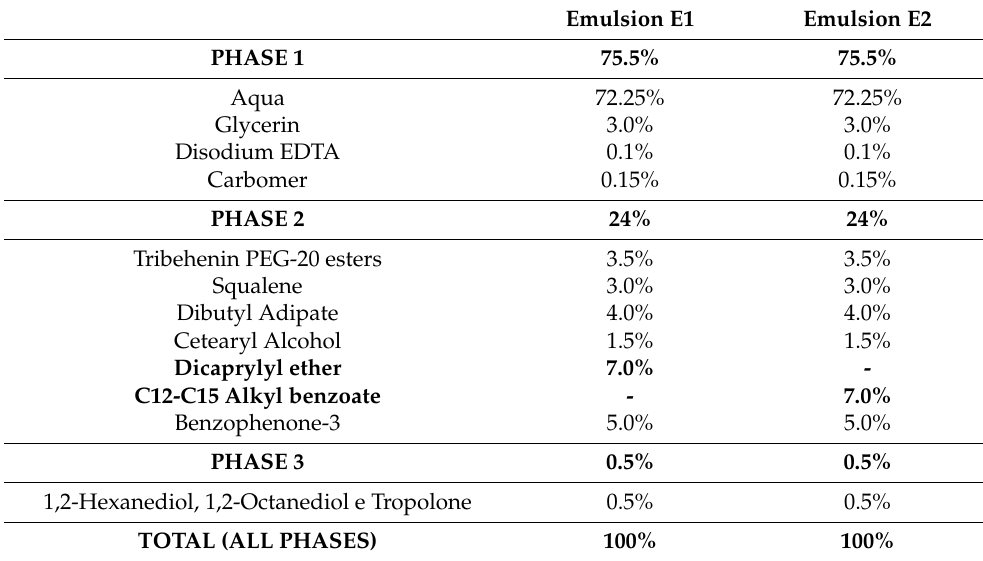
Table 9. Percentage composition of emulsion E1, containing O5 (Dicaprylyl ether), and emulsion E2, containing O6 (C12–C15 Alkyl